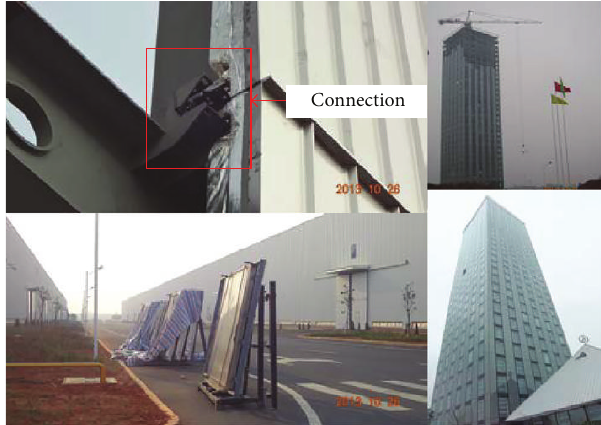
Figure 7: Installation of outer